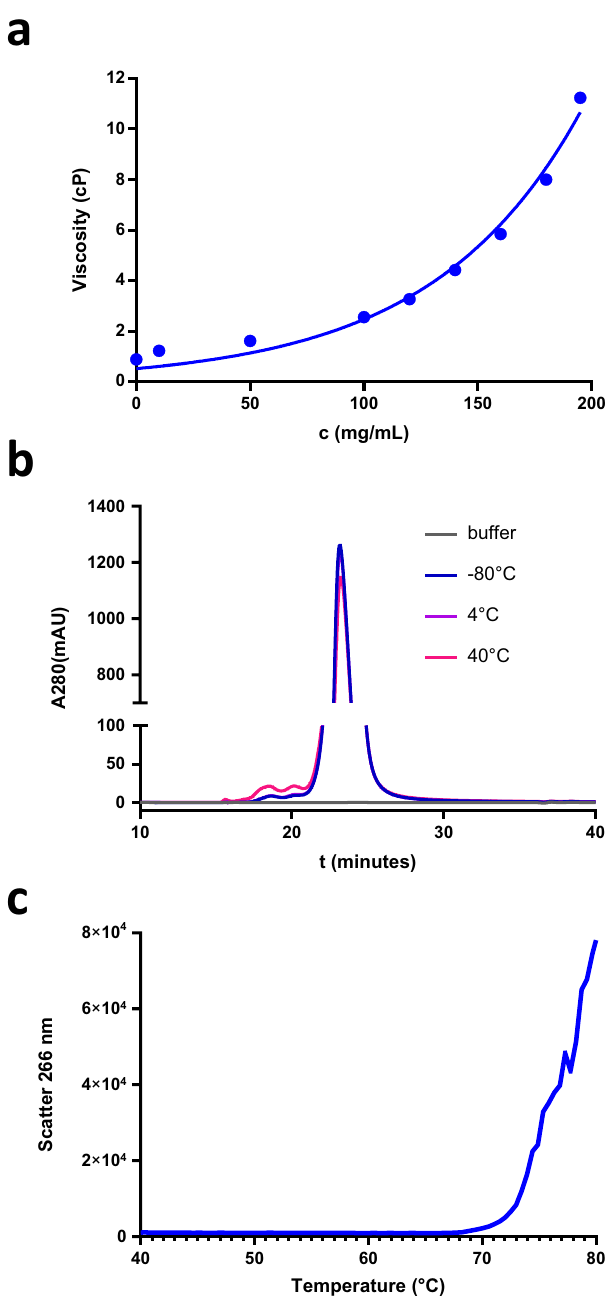
Fig. 7 CMC and biophysical properties of DutaFabs. a Viscosity of clone VP mat YHE (25 °C, 20 mM His pH 6.0). b Long-term RAC after PBS incubation, measured by SEC-HPLC after 4 weeks storage of clone VP mat YHE at 200 mg/mL. c Aggregation onset analysis of DutaFab clone VP mat YHE, 1 mg/mL, 20 mM His pH